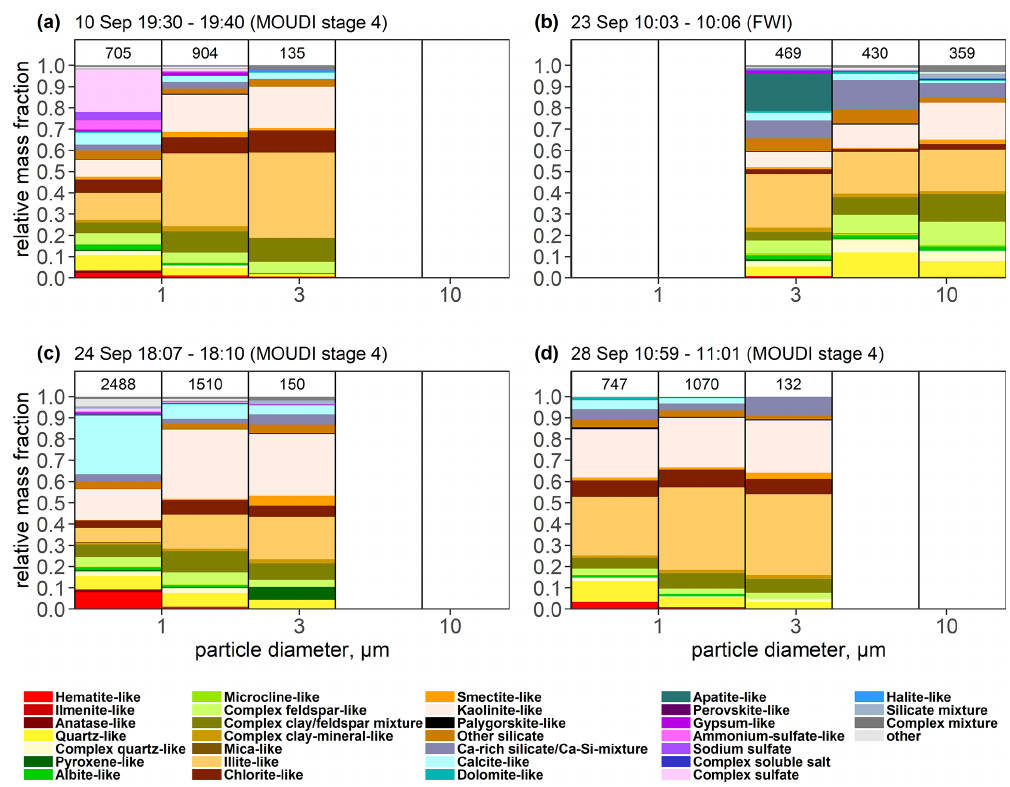
Figure 7. Phase compositions of size bins for samples collected under specific meteorological conditions at specific times and on certain days: (a) sulfate episode, (b) apatite particles, (c) Ca-rich episode, and (d) typical average composition. The total number of analyzed particles is given for each size class, but those with fewer than 30 particles are not